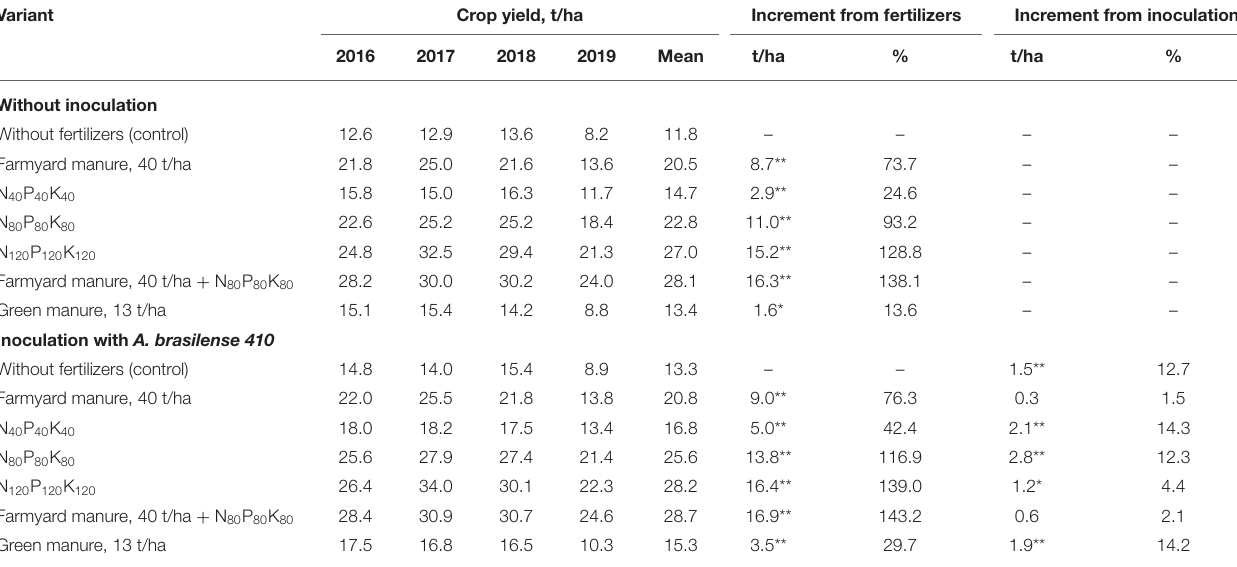
TABLE 3 | Potato crop yield under the action of fertilizers and inoculation. Variant Crop yield,